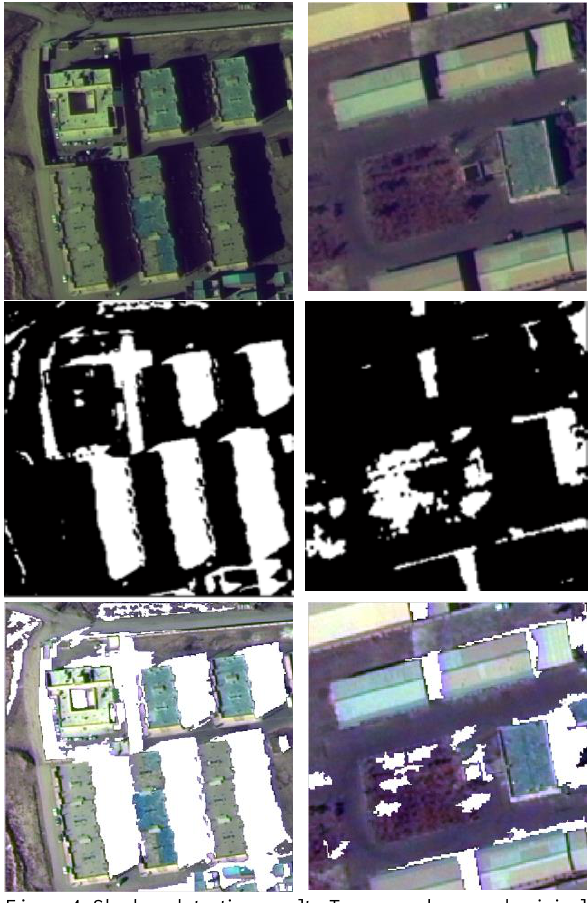
Figure 5. Disparity map refinement. Top: original epipolared left image; middle: Computed disparity map by SGM algorithm (the border of man-made objects drawn in red line); bottom: enhanced disparity map (proposed method) Also to visual inspection of shadow effect on SGM algorithm, the corresponding points and images were intersected and color point cloud is generated (Figure 6). Due to the existence of rational polynomial coefficients (RPCs) for satellite stereo images, the corresponding points are intersected by RPCs in the object coordinate system.